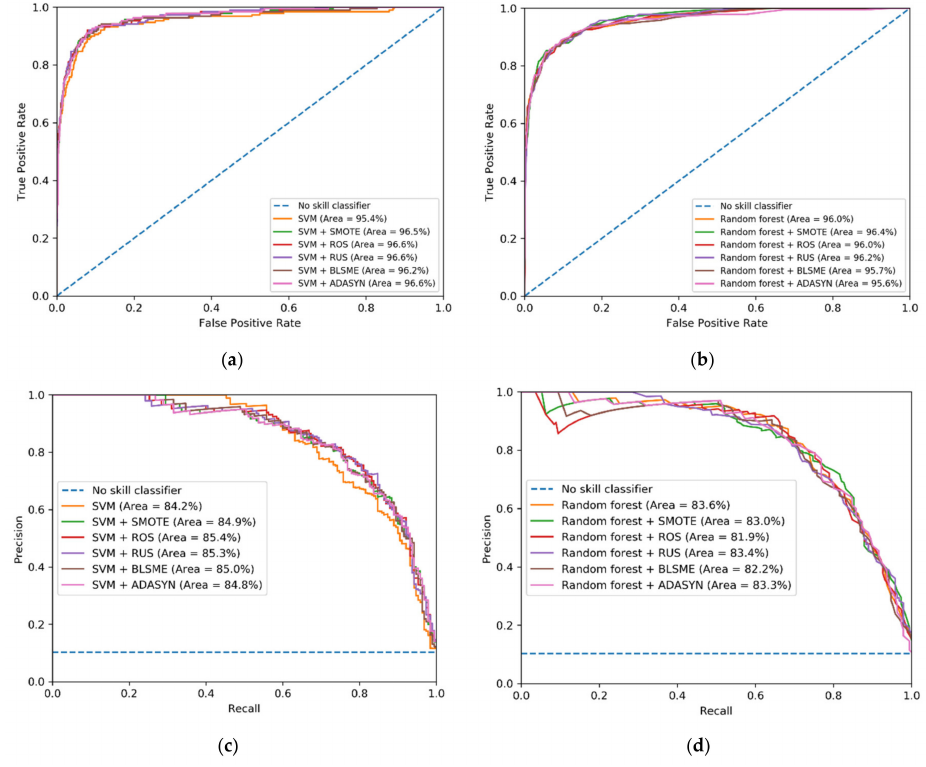
Figure A9. The ROC and PR curves of SVM and Random Forest for Fold 8; ( a ) the ROC curve of SVM; ( b ) the ROC curve of Random Forest; ( c ) the PR curve of SVM; and, ( d ) the PR curve of Random